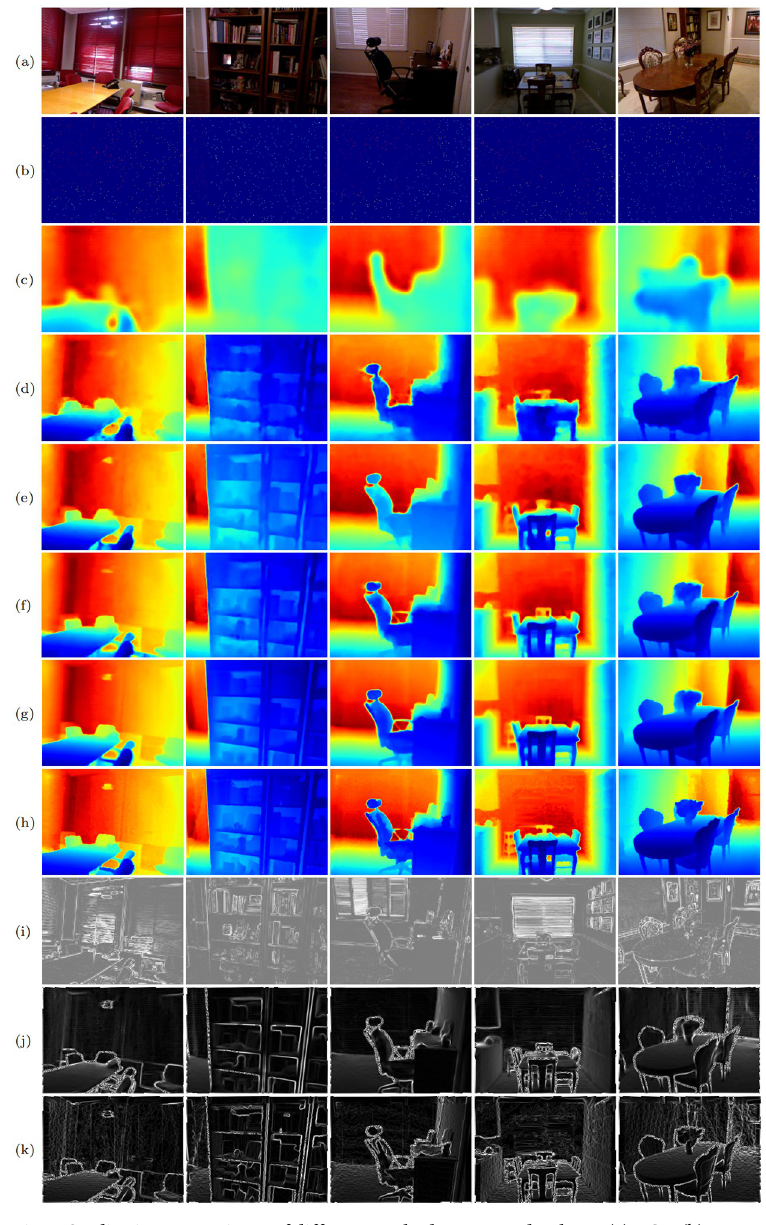
Fig 5. Qualitative comparisons of different methods on NYU-depth V2. (a) RGB, (b) sparse depth, (c) Sparse-to- Dense [21], (d) NConv-CNN [60], (e) CSPN [35], (f) GAENet [58], (g) SPNet (ours), (h) GT, (i) gradients from RGB images, (j) gradients from predicted depth, (k) gradients from GT